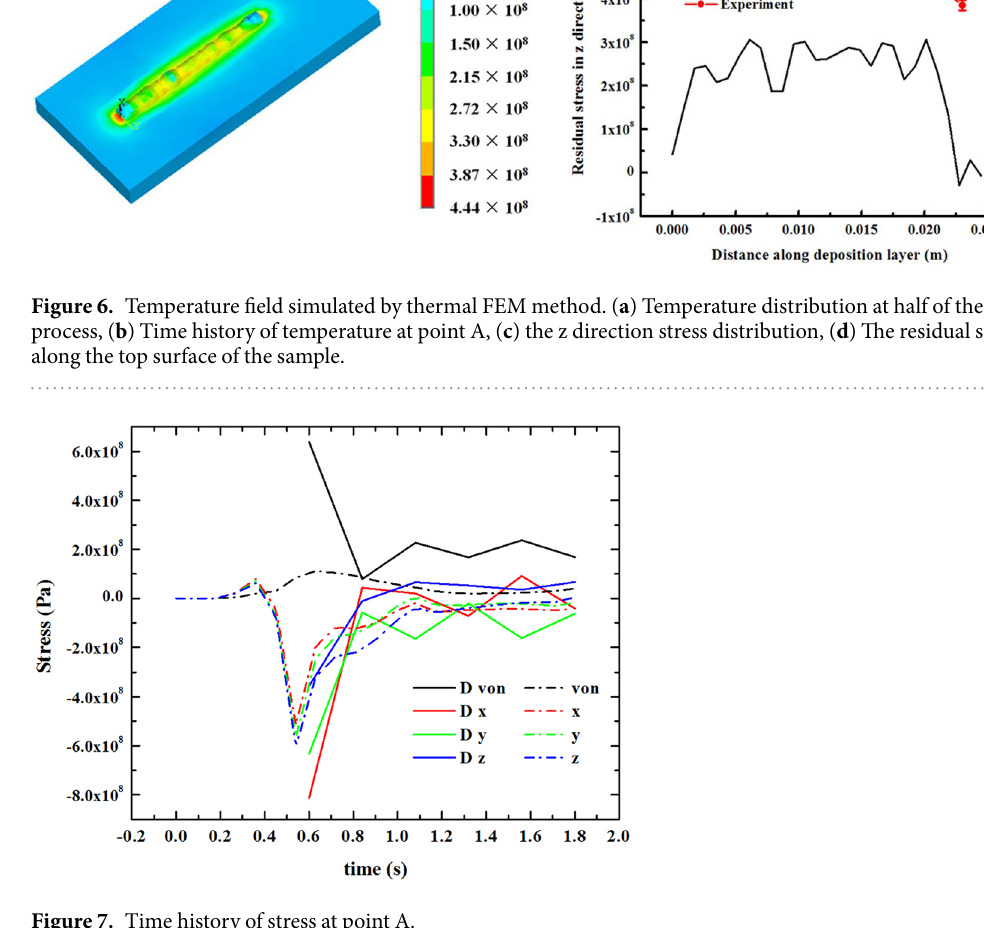
Figure 7. Time history of stress at point